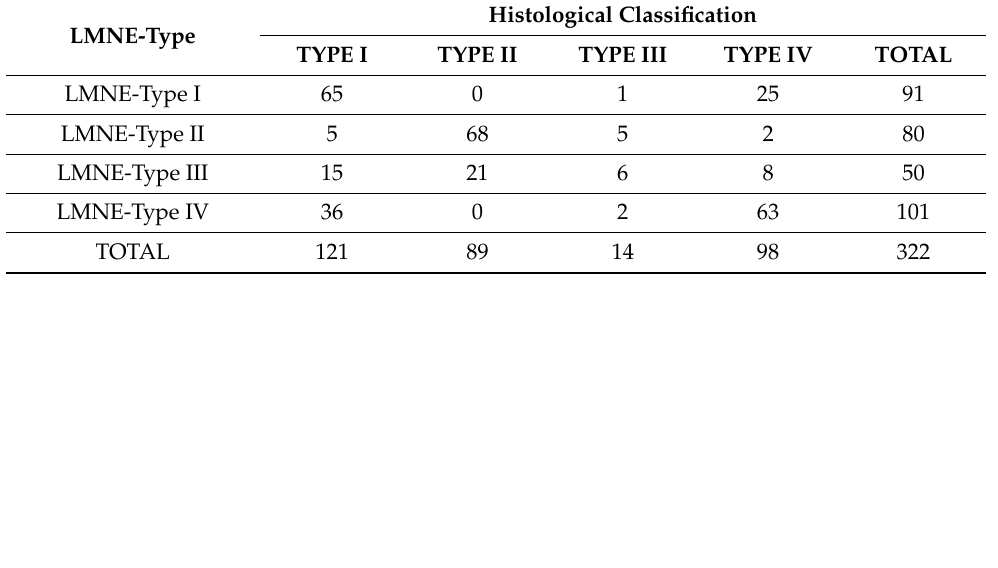
Figure 6. LMNE matrix of a type IV (indifference type) with no clear cloud or increase in cell types or particles in a 73 ‐ year ‐ old patient. The measured cell count was 240 cells/ μ L. or particles in a 73-year-old patient. The measured cell count was 240 cells/ µ L.